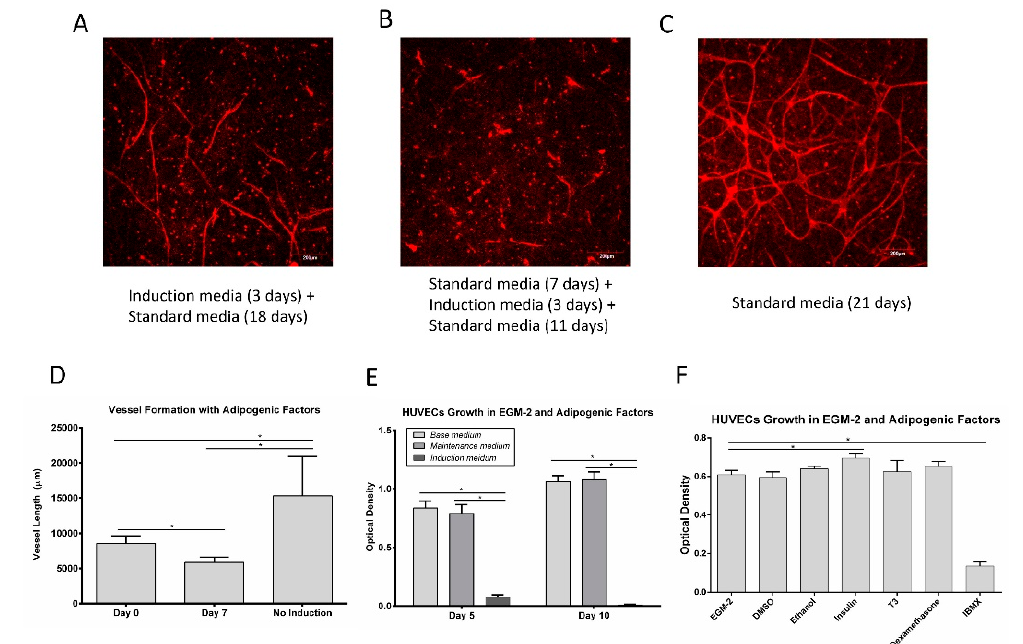
Figure 5. HUVEC vessel network formation ( A–D ) and HUVEC proliferation ( E , F ) in the presence of adipogenic factors. ( A ) Network formation with induction media added on day 0 and switched to standard media on day 3. ( B ) Network formation with induction media added on day 7 and switched to standard media on day 10. ( C ) Network formation under standard / control conditions. ( D ) Quantification of mean vessel length in different media conditions. Values are means ± SD, n = 4. ( E ) Proliferation of HUVECs in induction media and maintenance media compared to basal media controls. Values are means ± SD, n = 5. ( F ) Proliferation of HUVEC with exposure to individual adipogenic factors. Values are means ± SD, n = 6. For all the datasets, a one-way ANOVA followed by Tukey’s multiple comparisons test was performed. *Denotes significant difference ( p < 0.05) between groups.